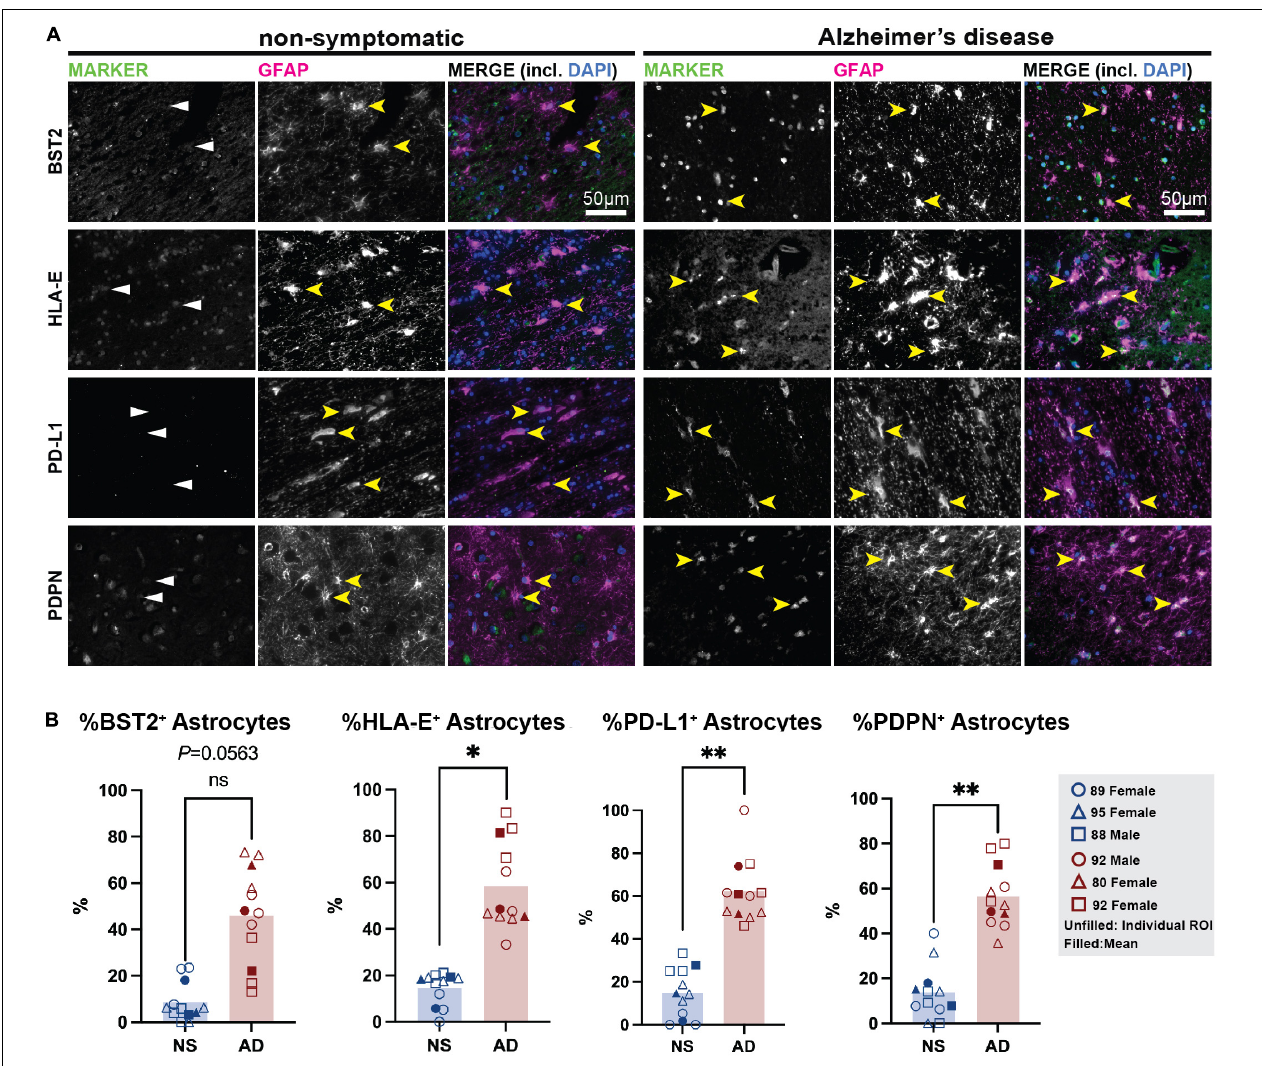
FIGURE 5 | Immunostaining for putative TIC-induced reactive astrocyte surface markers in human post-mortem brain. (A) Non-symptomatic (left) and Alzheimer’s disease (right) cortical sections were stained for BST2, HLA-E, PD-L1, and PDPN (all in green), and co-stained for the canonical astrocyte marker GFAP (magenta), and nuclear stain DAPI (blue). Yellow arrowheads mark astrocytes positive for GFAP (in NS brains) and/or specific cell surface reactive astrocyte marker (in Alzheimer’s brain samples). White arrowheads mark absence of reactivity markers in non-symptomatic brain. Scale bar = 50 µ m. (B) Quantification of BST2, HLA-E, PD-L1, and PDPN in human tissues. Plots show the individual points from each ROI (unfilled shapes), with means shown as filled shapes. Data are shown as percentage of double positive (Marker + /GFAP + ) cells over GFAP + astrocytes. *, p -value < 0.05; **, p -value < 0.01.